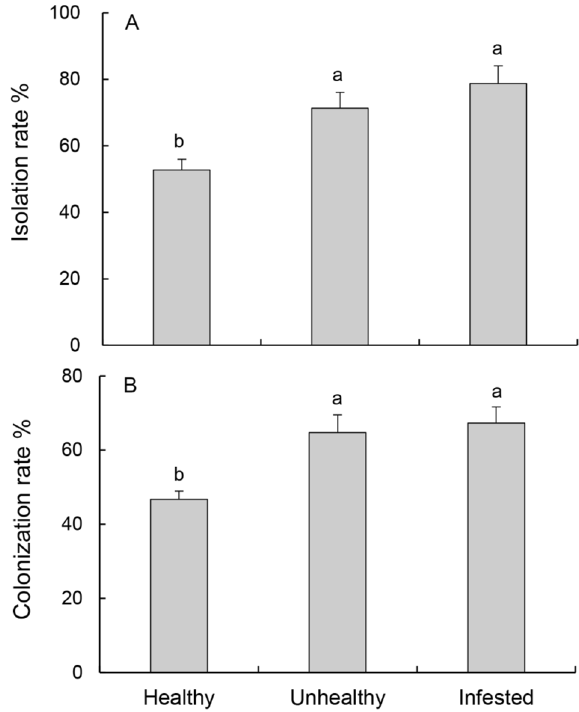
Figure 2. The rates of isolation ( A ) and colonization ( B ) of endophytic fungi from three tree samples. Bars and brackets are means and standard error, respectively. Different lowercase letters indicate a significant difference between the isolation rates or colonization rates in different tree samples at p <